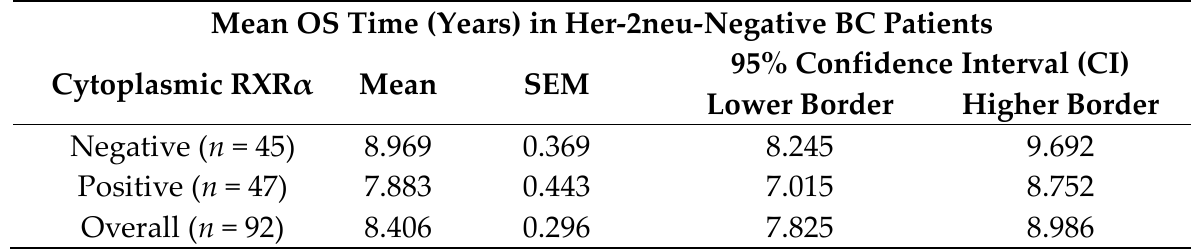
Figure 8. Kaplan – Meier survival analysis assessing cytoplasmic RXRα -positive expression in the Figure 8. Kaplan–Meier survival analysis assessing cytoplasmic RXR α -positive expression in the Her-2neu-negative patient Her-2neu-negative patient cohort in relation to OS. Statistical significance is shown as p -values cohort in relation to OS. Statistical significance is shown as p -values determined using the log-rank-test ( p < 0.05). The risk determined using the log-rank-test ( p < 0.05). The risk table demonstrates the mean survival. table demonstrates the mean